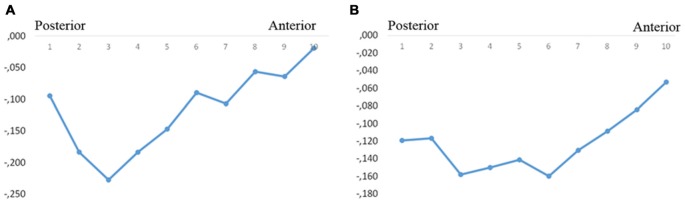
Correlations between subicular volume and CSF-P-tau levels. The figure denotes the correlation coefficients between the subicular volume segments and CSF P-tau in the whole group (A, left, B, right). Y-axis denotes the correlation coefficients. Dots denote volume segment moving from posterior (left) to anterior (right).